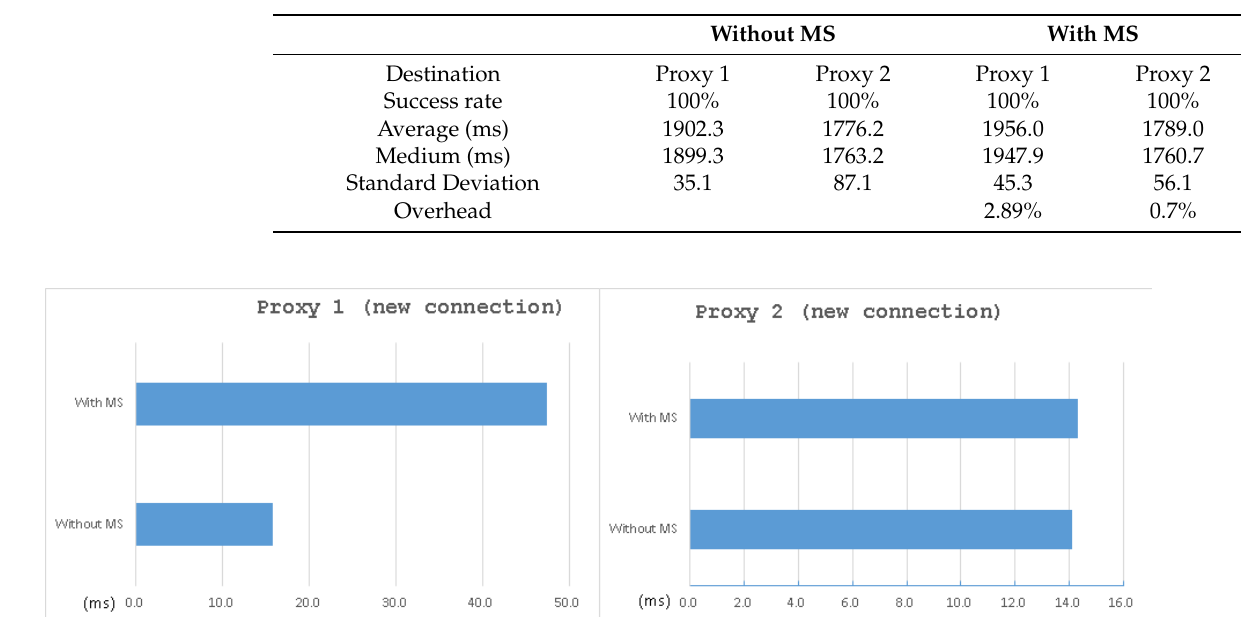
Figure 12. Average time of Proxy 1 and Proxy 2 when defending against DDoS attacks — new connection.